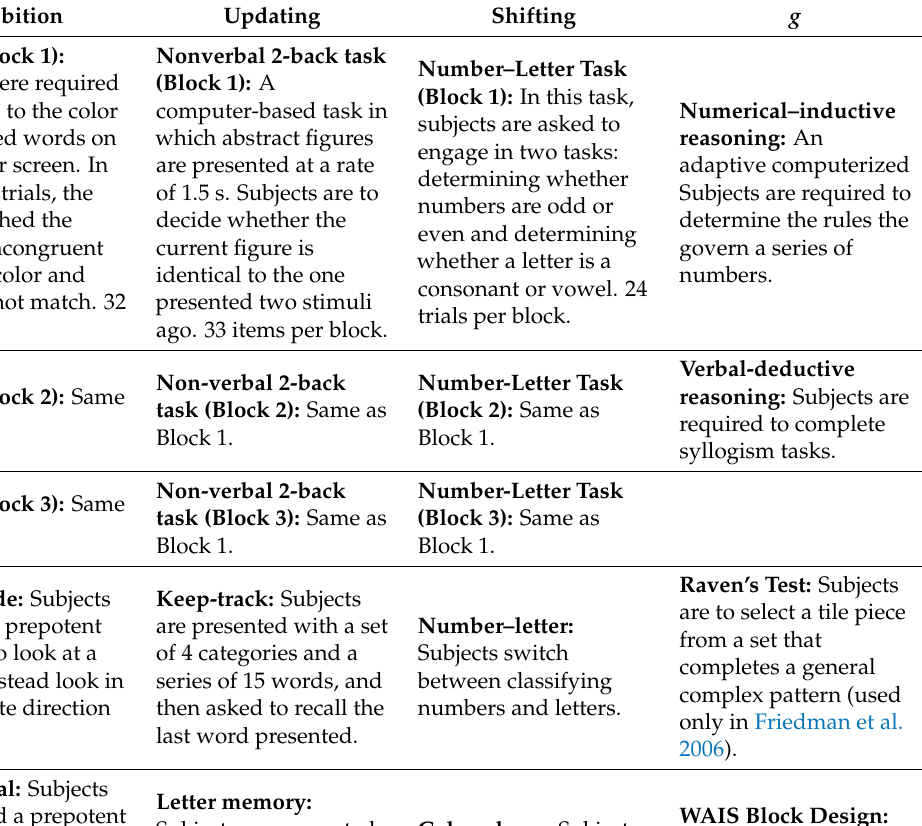
Table 2. Summary of executive function tasks and intelligence tests analyzed in Study